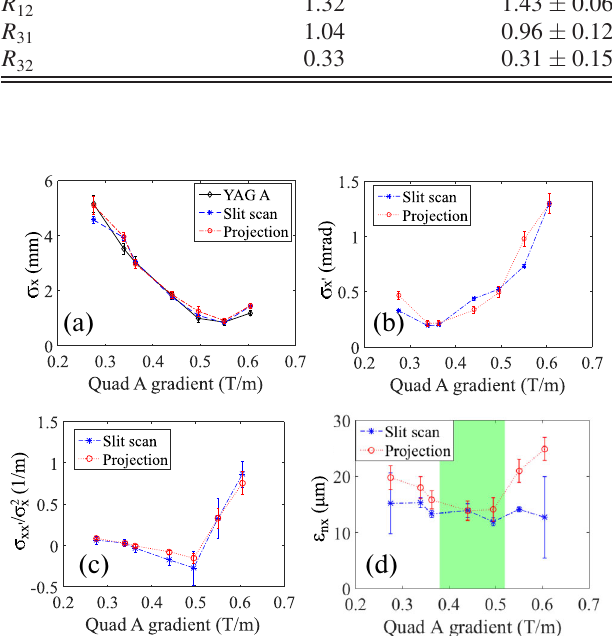
FIG. 4. Beam ’ s transverse second moments experimentally measured by slit-scan and projection-based diagnostic. Slit scan measured the second moments of the horizontally sliced beam, and the projection beam line projects this sliced beam for the measurement. The quad B gradient is set to − 0 . 41 T = m, while the quad A gradient